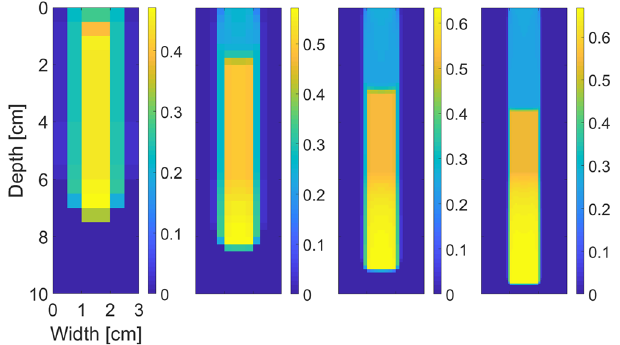
14.5 minutes for (cid:31) x 0.500 cm, 0.250 = = 0.002 . The moisture profile =